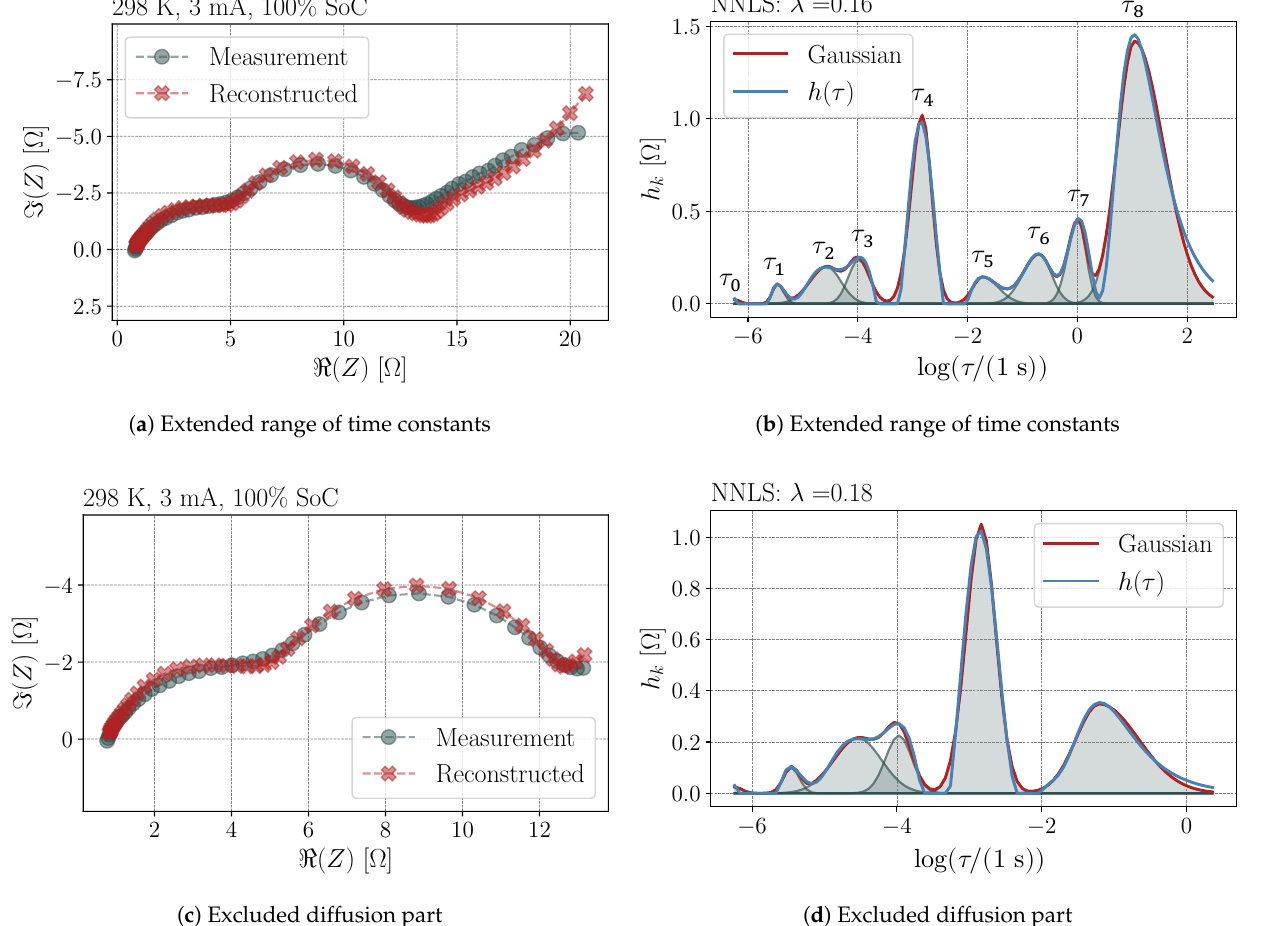
Figure A2. Improvement of DRT based on the extension of the time constant range ( a , b ) and on the exclusion of the diffusion parts ( c , d ). The EIS and the reconstructed impedance spectrum related to the DRT is depicted in ( a , c ) and the corresponding DRT in ( b , d ).